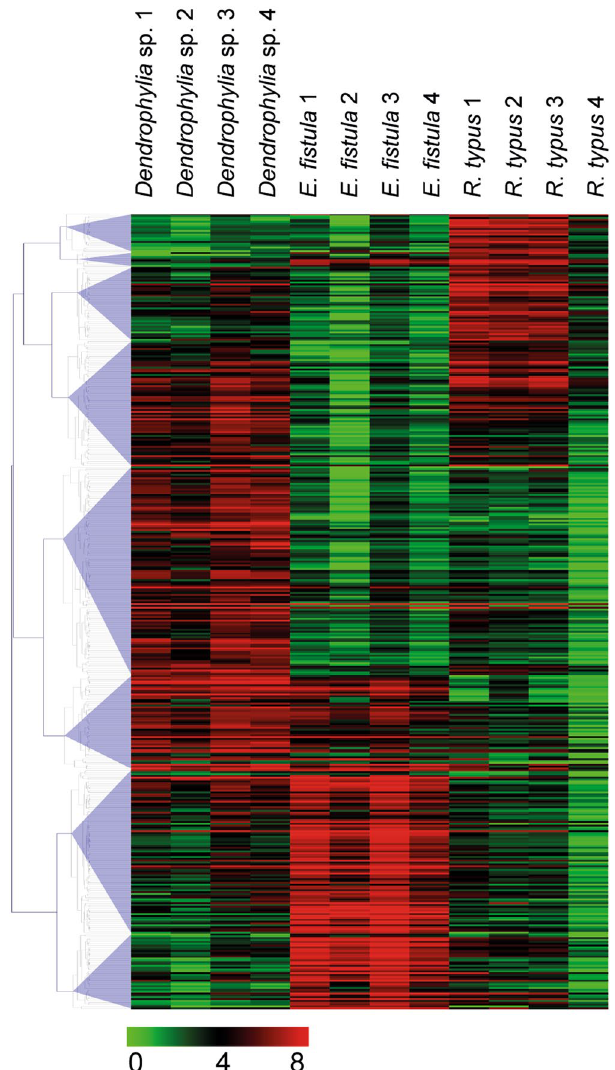
Figure 3. Heatmap of 431 differentially expressed orthologous genes between Dendrophyllia sp., E . fistula , and R . typus . Colors denote log 2 (x + 1) transformed FPKM